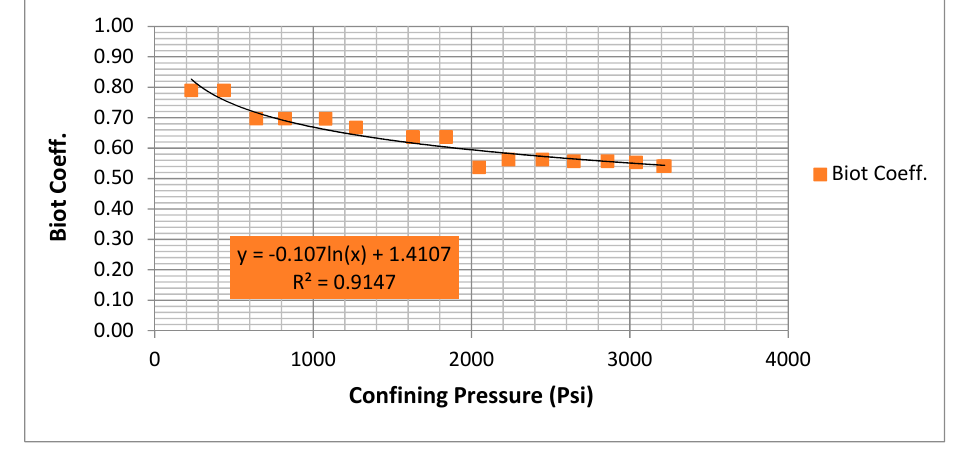
Figure 9. Biot coefficient vs. confining pressure for C4.